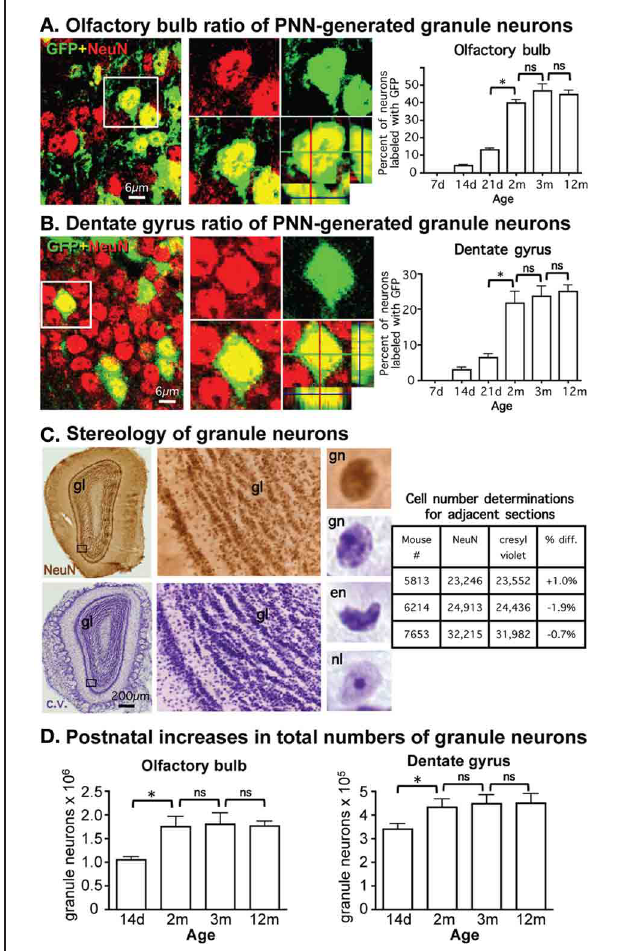
FIGURE 1 | Pronounced continual addition of granule neurons to OB and DG throughoutjuvenile development. (A,B) Gradually increasing ratio of postnatally generated neurons during postnatal development in OB and DG. Photomicrographs show confocal optical slices through OB (A) and DG (B) granule cell layers (GCL) from adult mGFAP-Cre-Z/EG reporter mice, stained green for the reporter, GFP, and red for the neuronal maker, NeuN. Graphs show ratios of granule neurons double-labeled for NeuN plus GFP, and therefore, derived from PNN, relative to the total population of NeuN labeled granule neurons at various postnatal ages in mGFAP-Cre-Z/EG reporter mice, expressed as % (GFP + NeuN/NeuN × 100). ∗ p < 0 . 05 ANOVA with Neuman–Keuls pairwise analysis; ns = not significant; n = 3 per group; d = day; m = month (C) Stereological analysis of cresyl violet (c.v.) and NeuN brightfield immunohistochemically stained OB tissue yield indistinguishable estimates of total numbers of granule neurons. Photomicrographs show surveys and details of adjacent OB frontal sections stained with immunohistochemistry for NeuN or c.v.; while c.v. labels moref cells, at high magnification granule neurons (gn) stained with NeuN or c.v. are morphologically the same and are easily distinguished from other cells, such as endothelia (en), cells with prominent nucleoli (nl) or small glia, which were not counted. Table shows that unbiased stereological cell counts of granule neurons stained with NeuN and c.v. are indistinguishable and do not differ significantly (ANOVA p > 0 . 05). (D) Significant increase in total numbers of granule neurons during postnatal development in OB and DG. Graphs show total numbers of granule neurons obtained using unbiased stereology in at various postnatal ages in OB and DG. ∗ p < 0 . 05 ANOVA with Neuman–Keuls pairwise analysis; ns = not significant; n = 4 or 6 per